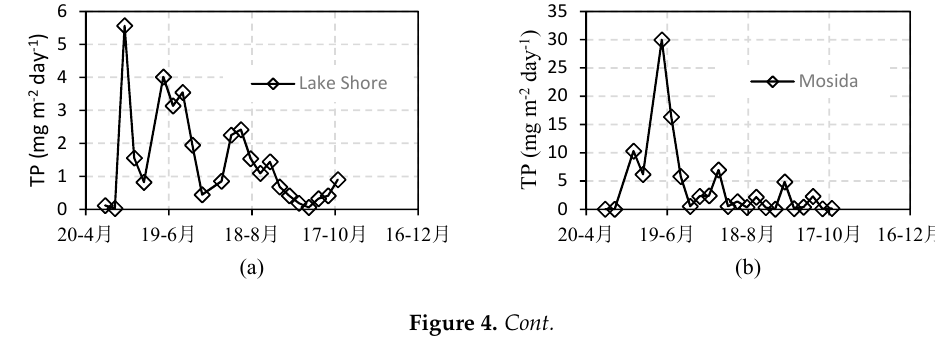
Table 4. Summary for dissolved inorganic nitrogen (DIN) deposition data from May 2017 through December 2017.